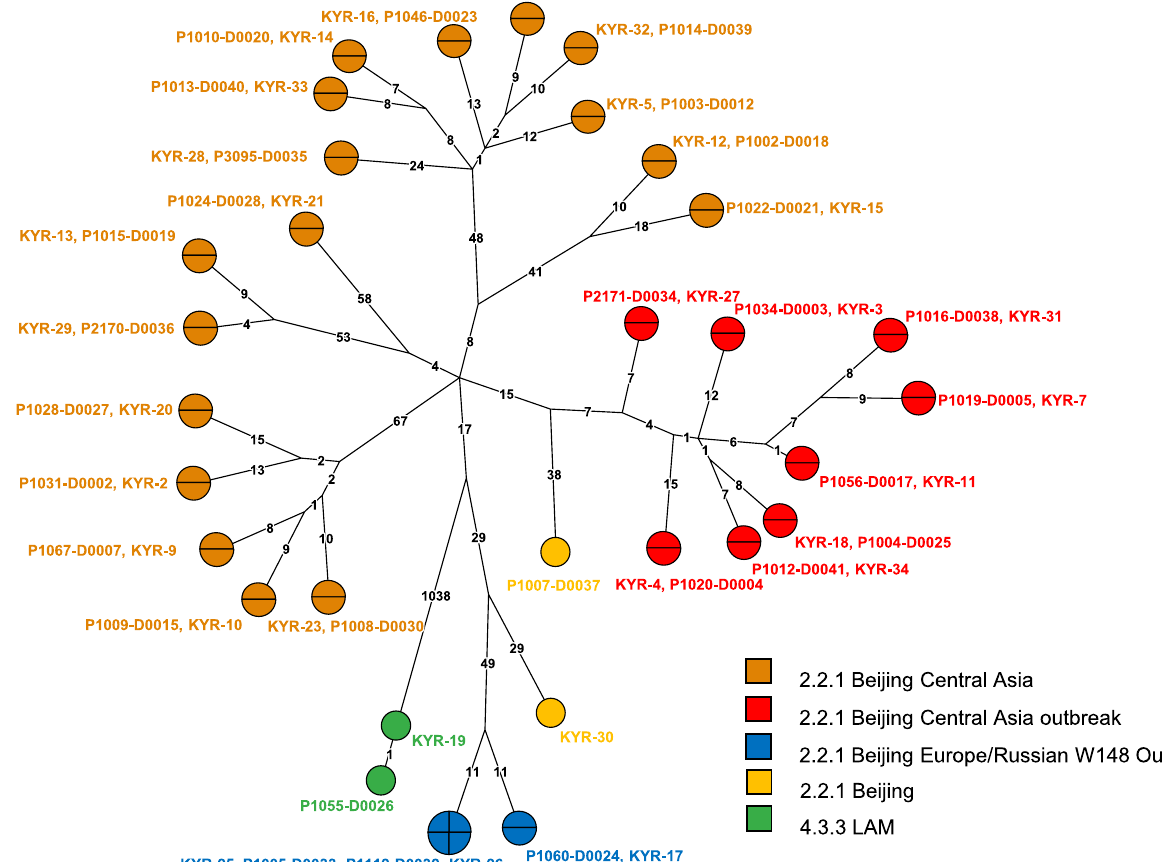
Figure 1. External quality control by interlaboratory comparison of 30 pairs of WGS of random clinical Mtbc isolates independently produced by Kyrgyz NRL and RCB. Genotypes are indicated for the sake of completeness according to Merker et al. 31 . For 28 analyzed datasets, the calculated pairwise distances were zero. Two samples yielded divergent pairs of results. The DNA sample pair KYR-19/P1055-D0026 (green dots) showed a wild-type and a SNP population each of approximately 50% at the divergent position (further details see Fig. S2). KYR-30 and P1007-D0037 (yellow dots) were derived from a mixed infection with two Mtbc strains of Beijing 2.2.1 lineage. The presence of two alternative allele clusters at a frequency of approximately 40–60% resulted in either the wildtype or alternative alleles being identified and reported by NRL and RCB at the variant